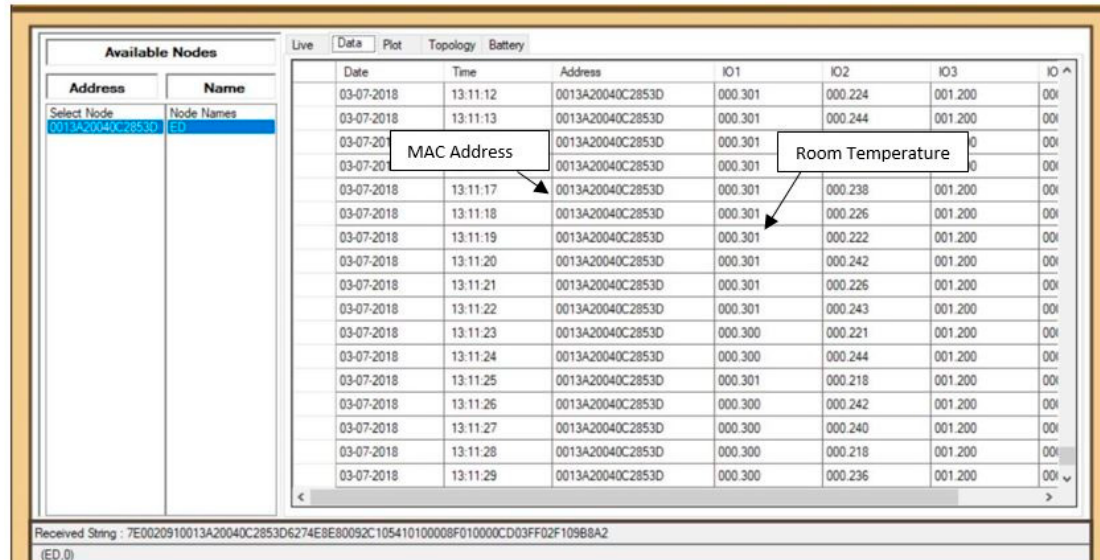
Figure 15. Temperature monitoring readings of the SEH-WSN node on a personal computer.